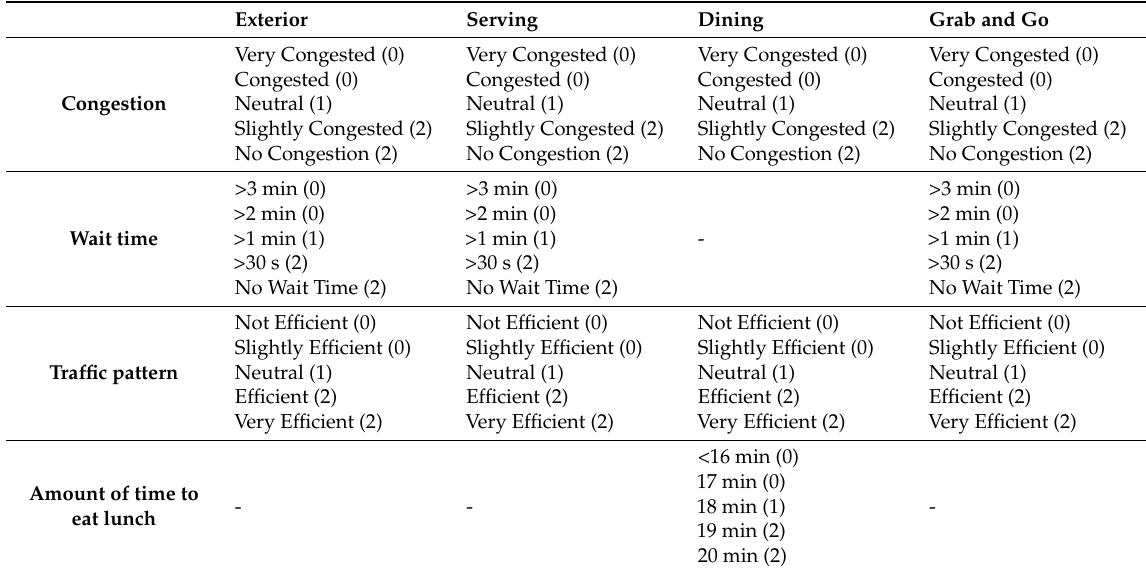
Table 2. Video assessment tool evaluation content for each area of the cafeteria environment.